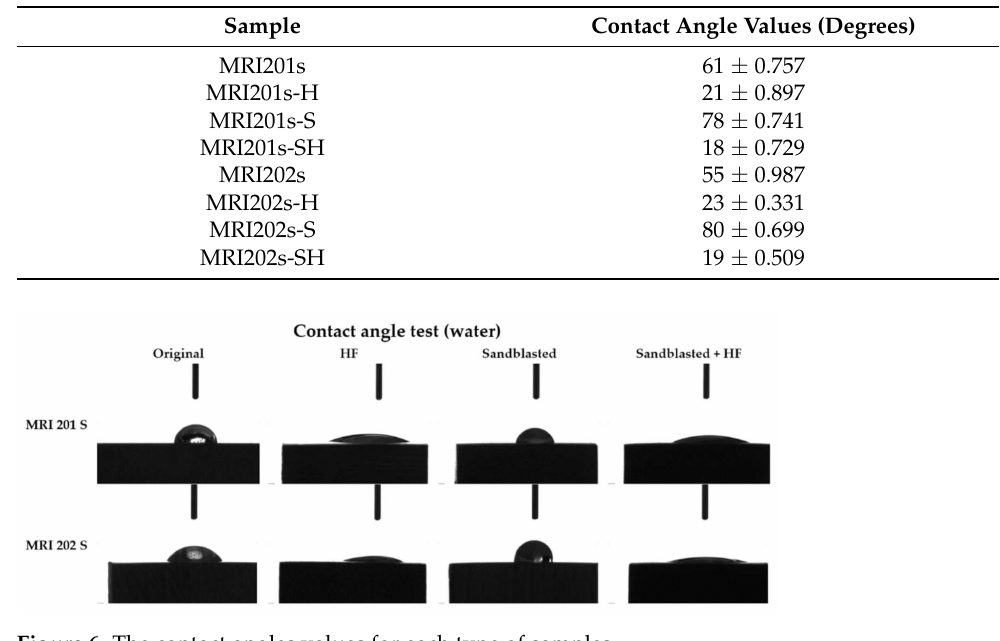
Figure 6. The contact angles values for each type of samples.